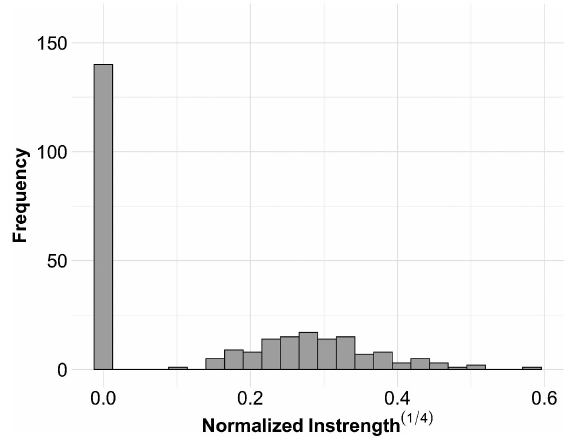
FIG. 7. Histogram of the normalized instrength data using the fourth root transformation. Though we maintain a peak at zero, the rest of the data exhibit a fairly normal